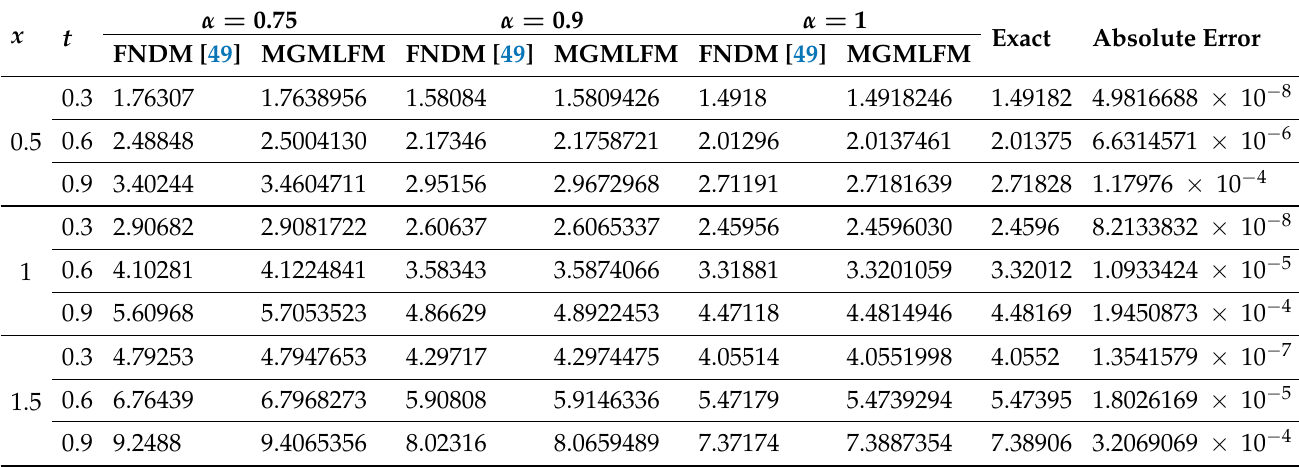
Table 5. Values of approximate solutions obtained by MGMLFM, FNDM, exact solution, and absolute errors of V for system (5) with various values of α , t , x and y =